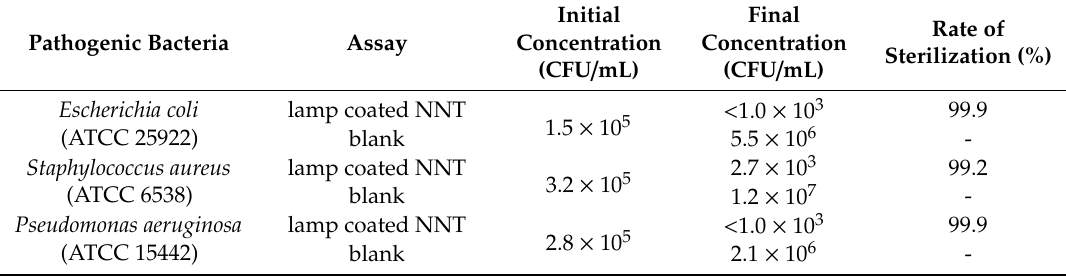
Table 1. Antibacterial properties of NNT thin films coated on polycarbonate in visible light.